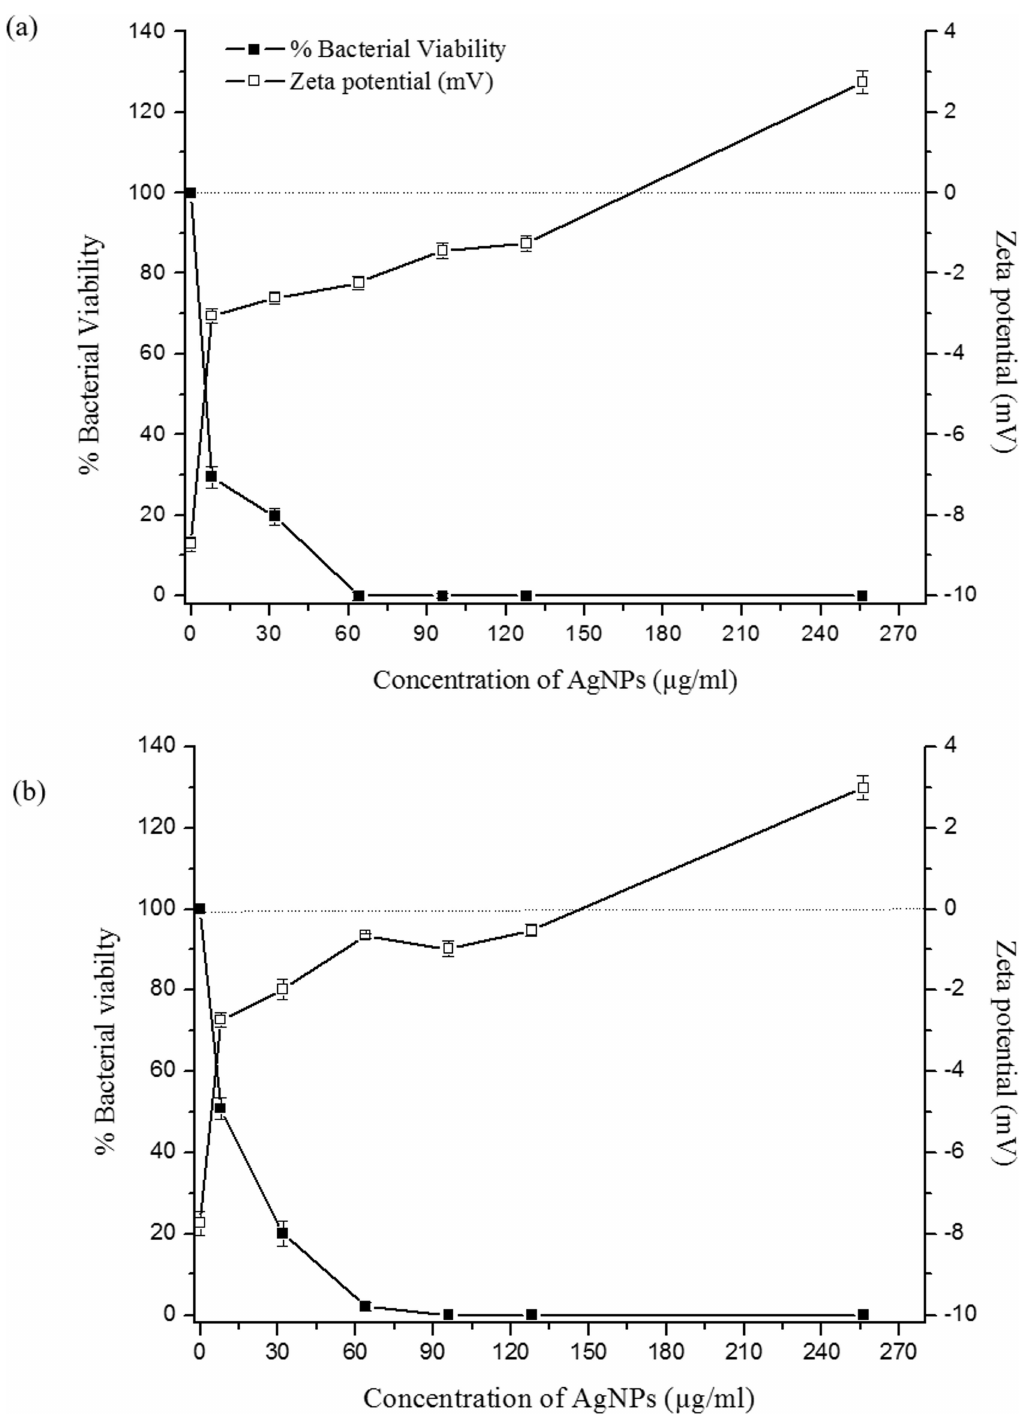
Fig 4. Effect of AgNP on bacterial viability and cell-surface charge of B . pseudomallei . B . pseudomallei NF10 (a) and 316c (b) were treated with AgNP concentrations of 8, 32, 64, 96, 128 and 256 μ g/mL. Black squares corresponds to the percentage of viable bacterial cells in the presenceof increasing AgNPs concentrations, whereas the zeta potentialis indicatedby the white squares. The dotted line indicates a neutral surface net charge, to highlight the AgNP concentration range at which both strains of B . pseudomallei exhibit surface neutrality and possible overcompensation is achieved.Data represent the means ± standard errors of the means for triplicate samples. Results shown are representative of two